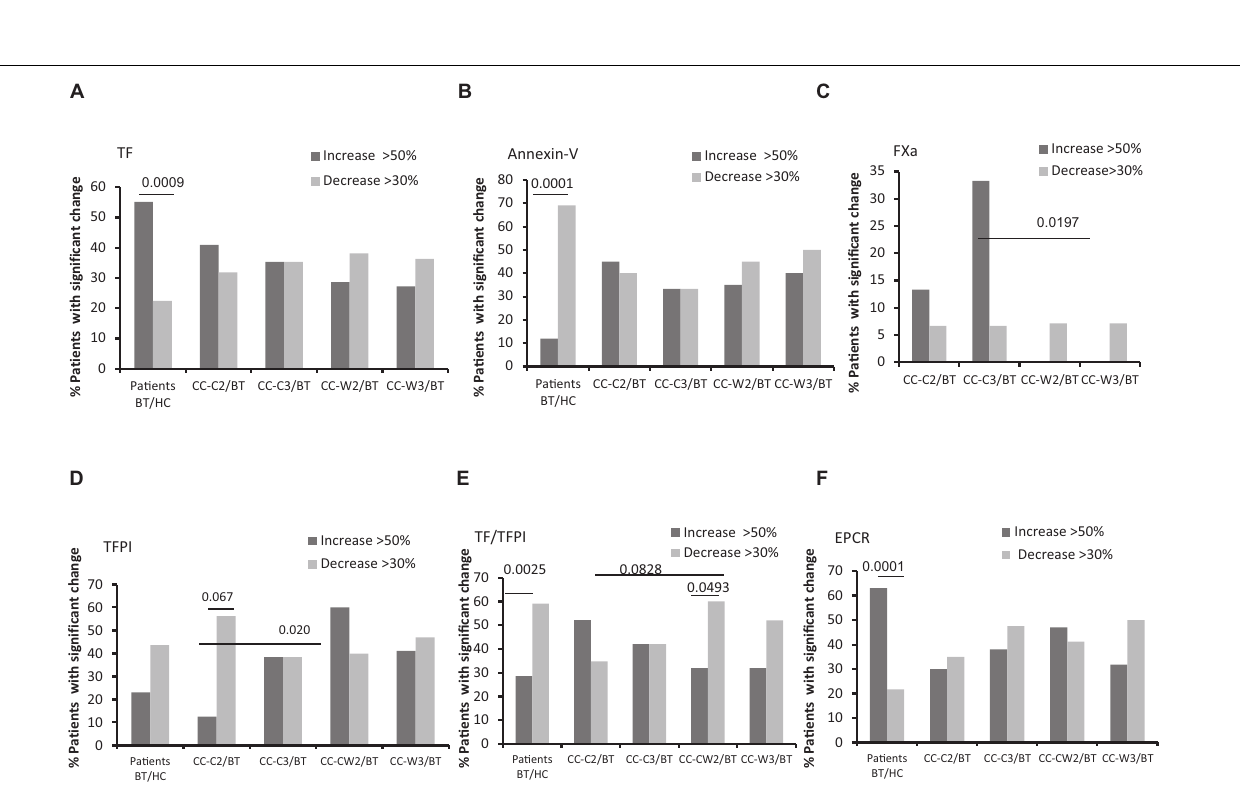
Frontiers in Oncology |